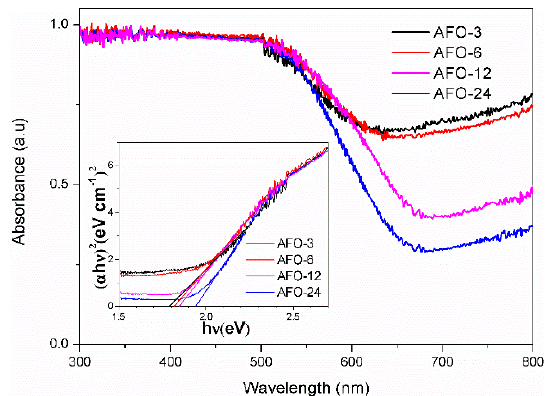
Figure 4. UV ‐ vis absorption spectra of as ‐ prepared AgFeO 2 photocatalysts with different hydrothermal time. The inset shows the plots of ( α h ν ) 2 versus h ν for the samples.